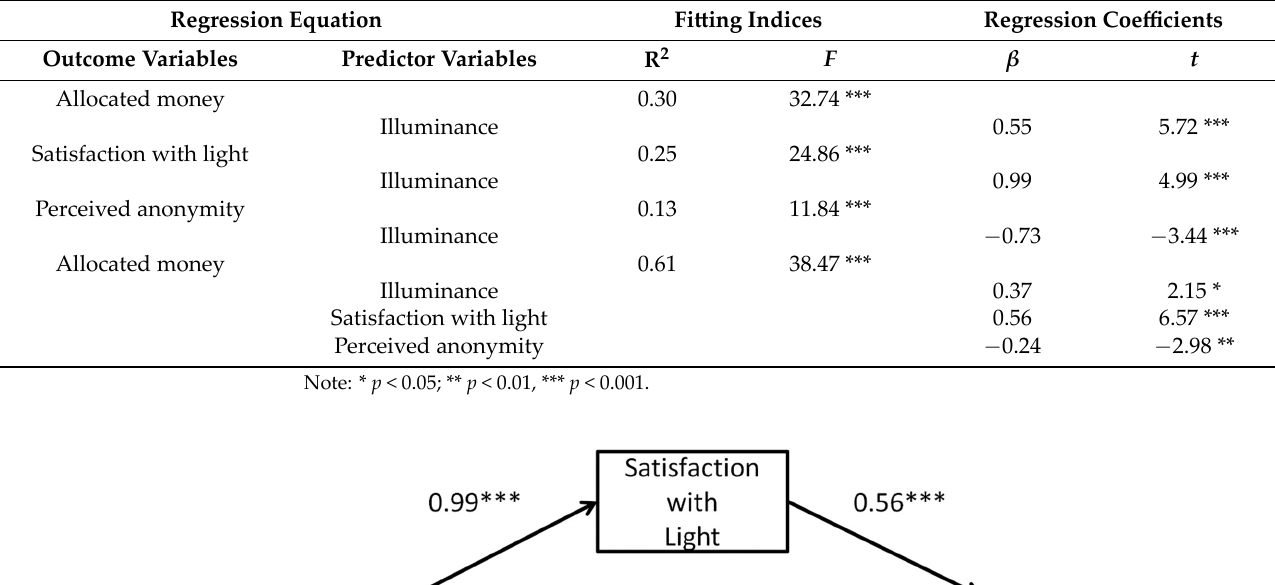
Table 5. Results of regression analyses.